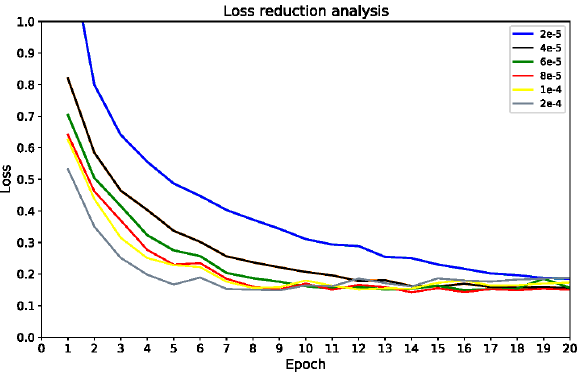
Figure 8. Loss convergence diagram for different learning rates of the